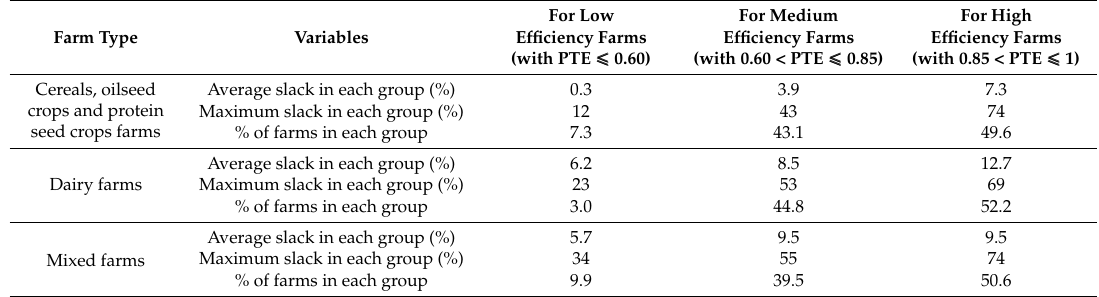
Table 9. Slacks of energy resource depending on farms’ pure technical efficiency